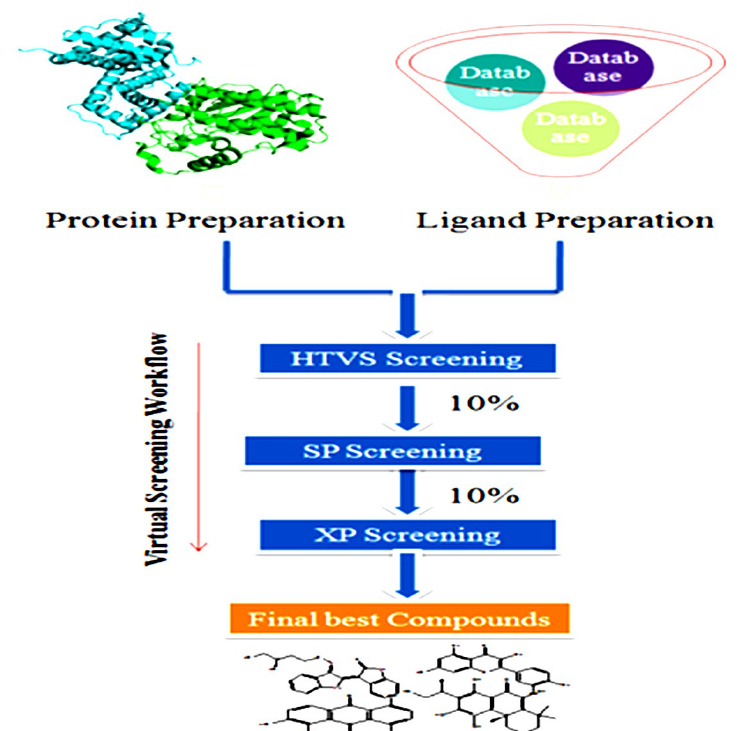
Fig. 6. Structure-based virtual screening